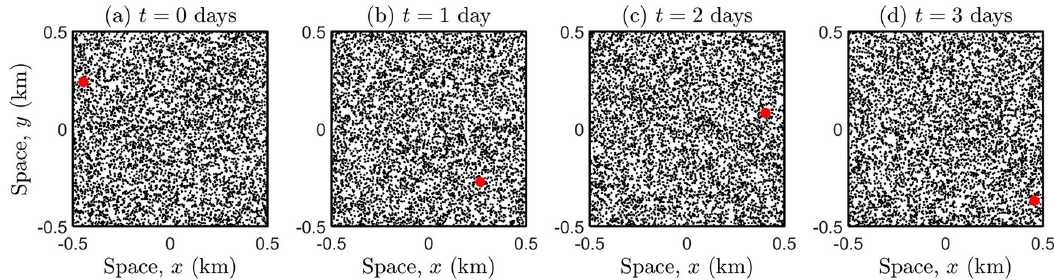
Fig 3. Snapshots of the interplay between an infectious host (red marker) and the susceptible population (with density ρ = 5700) at times t = 0, 1, 2, 3 days. The initial location of the infectious host is completely random, over a region of size 1km by 1km. Each individual in the population (including the infectious host) performs a SRW with mobility parameter σ = 0.1 and null mean cosine. Time is computed as t = n Δ t with Δ t = 0.025, so that each individual executes a maximum of n = 2880 steps corresponding to t = 3 days. Red marker is enlarged for illustrative purposes.